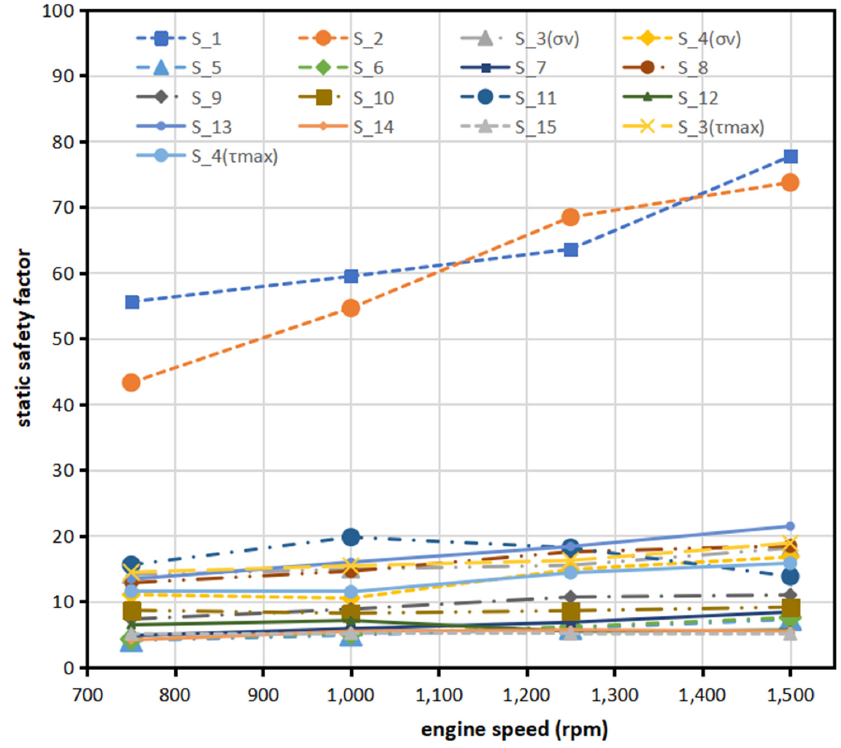
Figure 11. The average static safety factor of the transplanting device according to the engine speed.